Question: Does the plotted quantity increase or decrease?
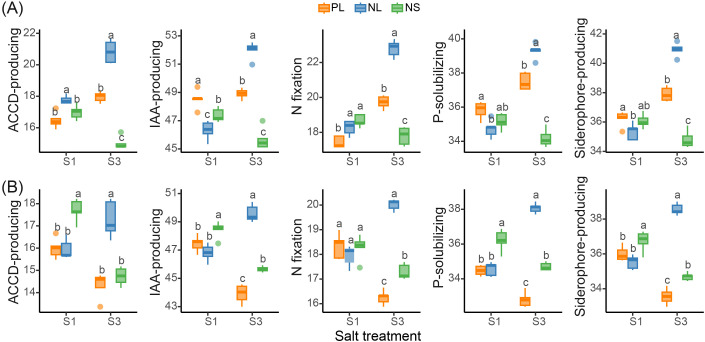
Answer: increasing